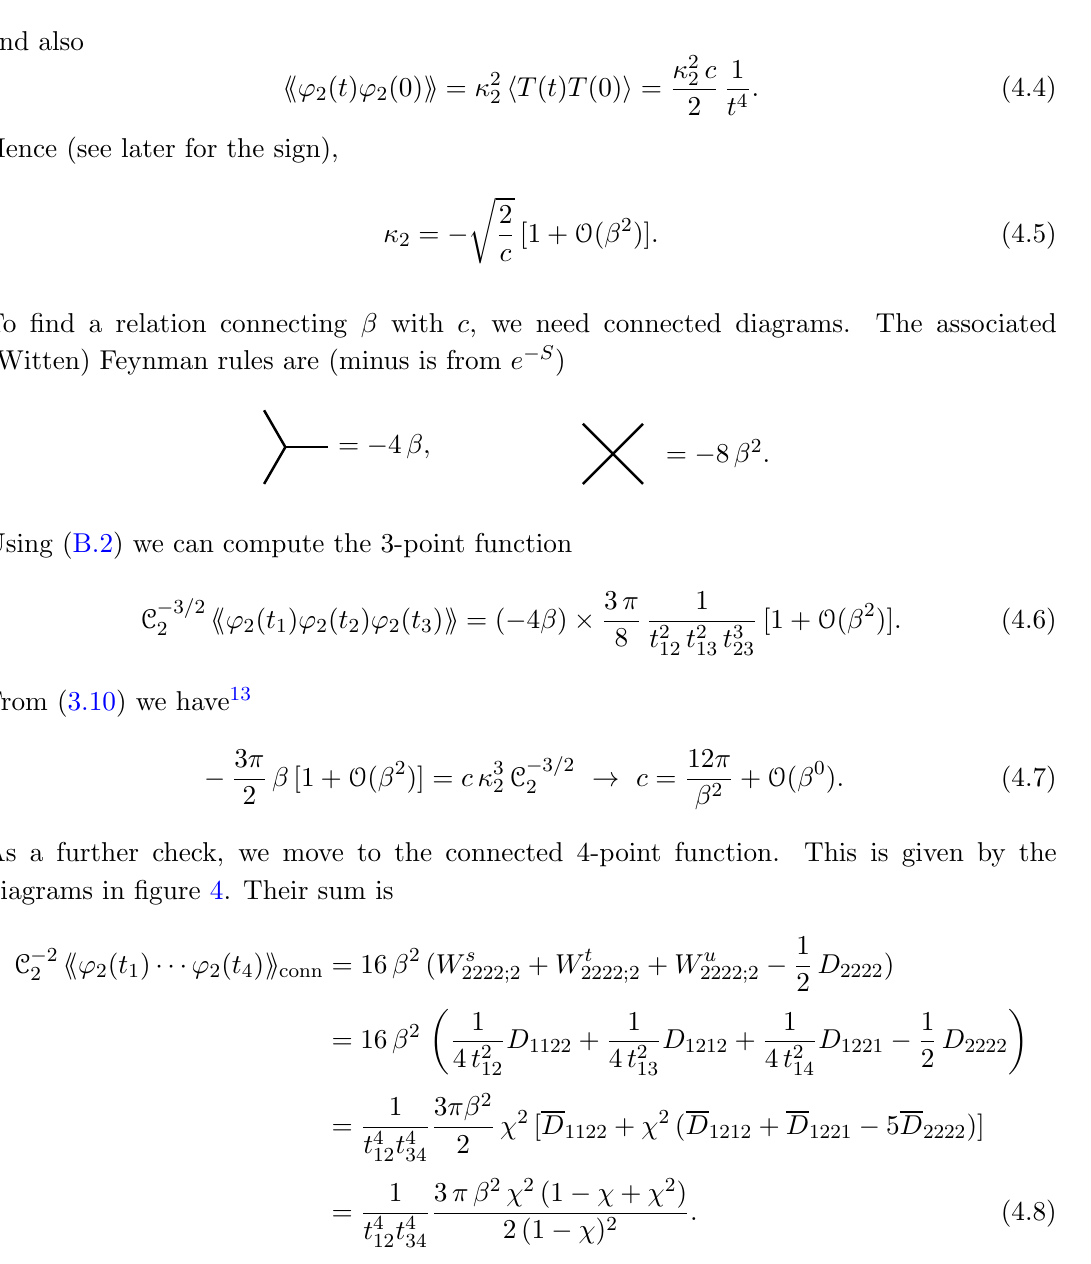
Figure 4 . Tree diagrams contributing ⟪ ϕ 2 ϕ 2 ϕ 2 ϕ 2 ⟫ . The external points and internal exchange are labeled by their